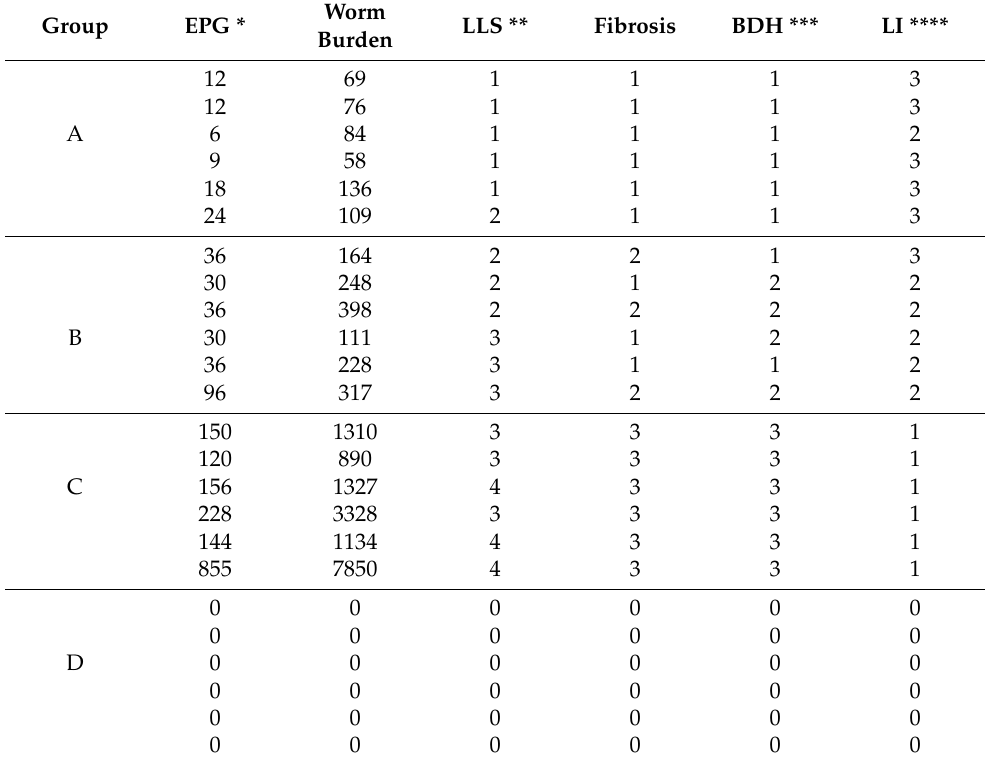
Table 1. Results of the coprological analysis (EPG values), post-mortem examination (worm burden), and scoring assigned to macroscopic and histological alterations. * EPG: egg per gram; ** LLS: